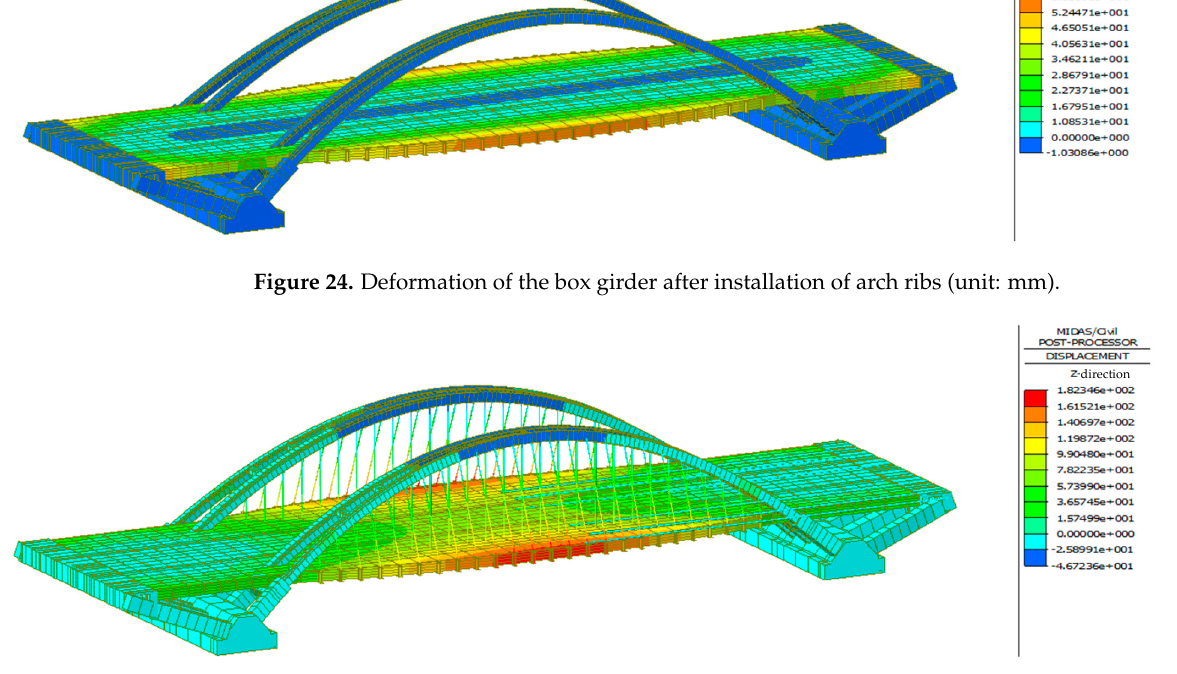
Figure 25. Deformation of the box girder after the demolition of the frame scaffolding (unit: mm).